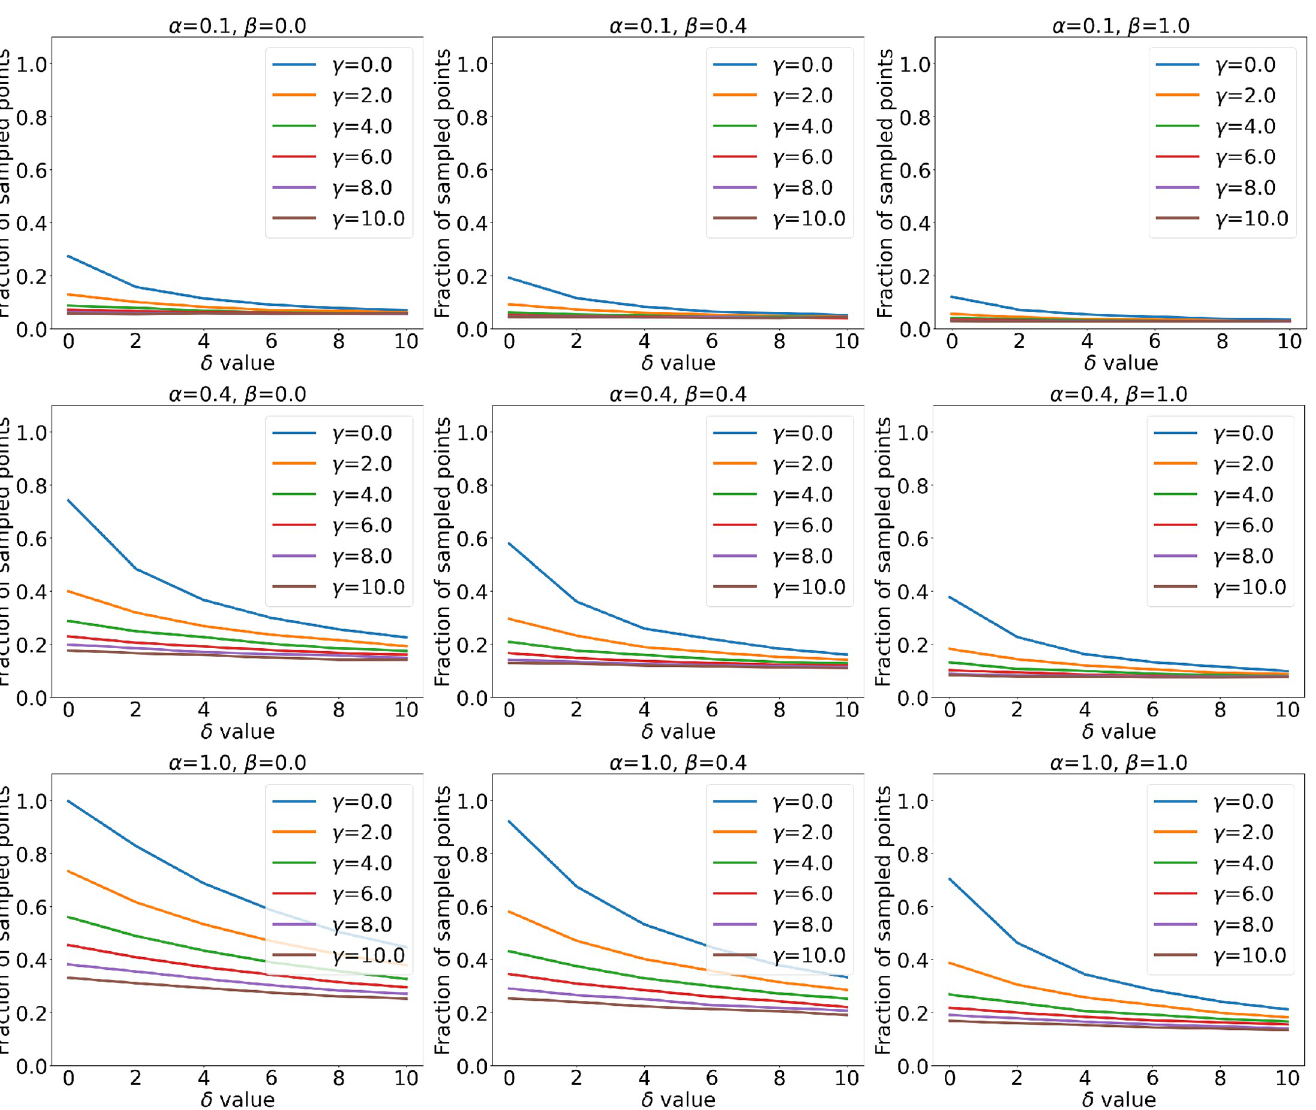
Fig 2. Sampled points fractions for varying parameters. Percentage of surface points that are sampled by varying α , β , γ and δ . These plots were obtained after the sampling of the surface of A1.